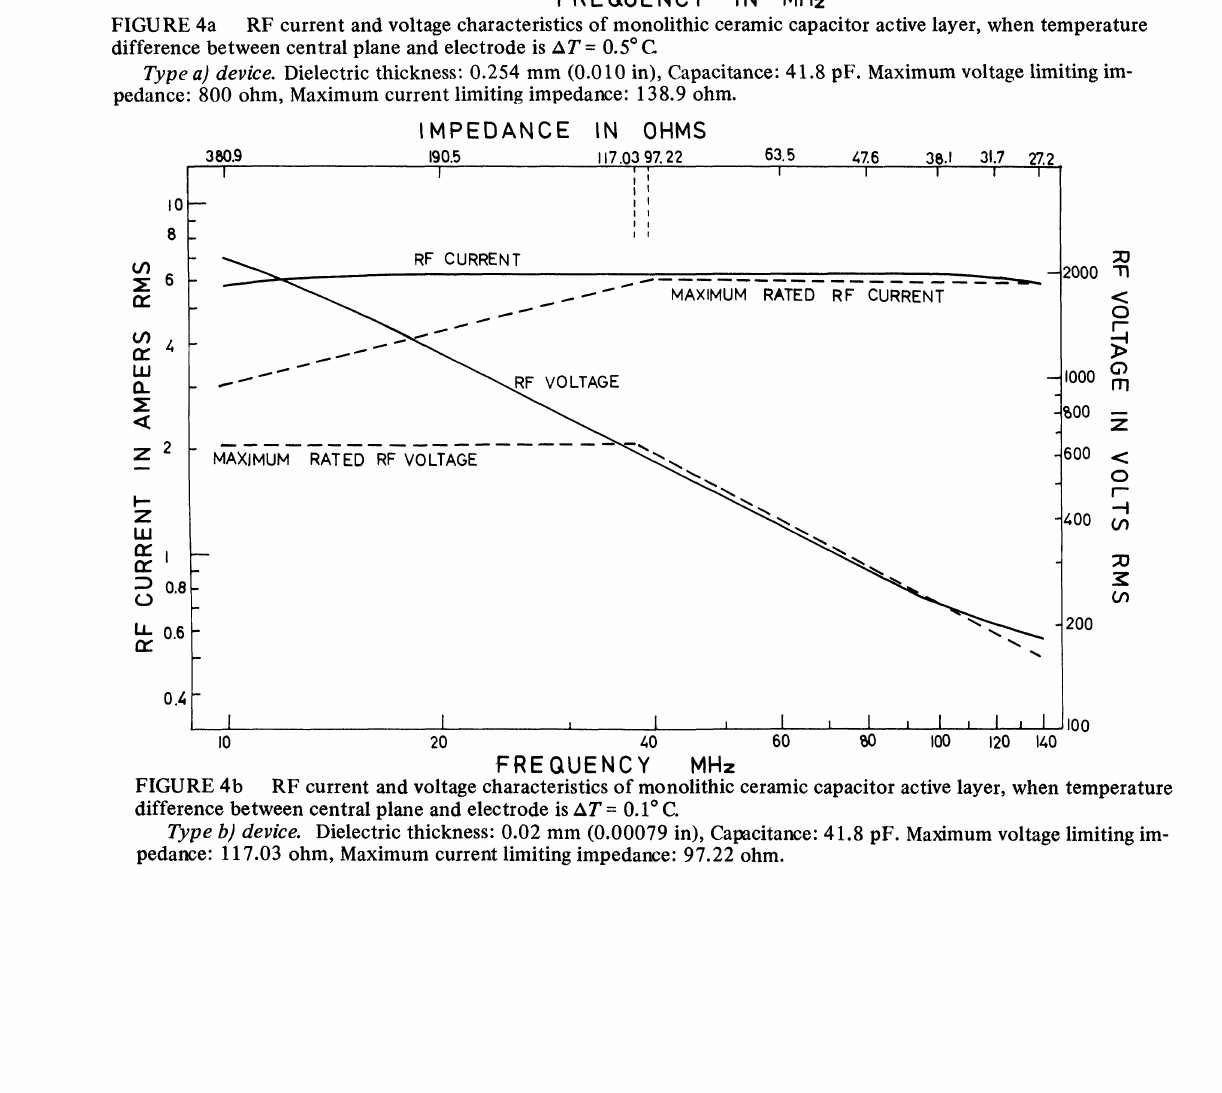
FIGURE 4b difference between central plane and electrode is AT 0.1 C. Type b) device. Dielectric thickness: 0.02 mm (0.00079 in), Capacitance: 41.8 pF. Maximum voltage limiting im- pedance: 117.03 ohm, Maximum current limiting impedance: 97.22